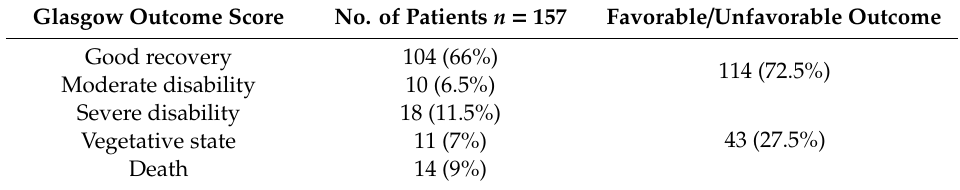
Table 2. Outcome of patients with subarachnoid hemorrhage with ACoAA; GOS after three months. Glasgow Outcome